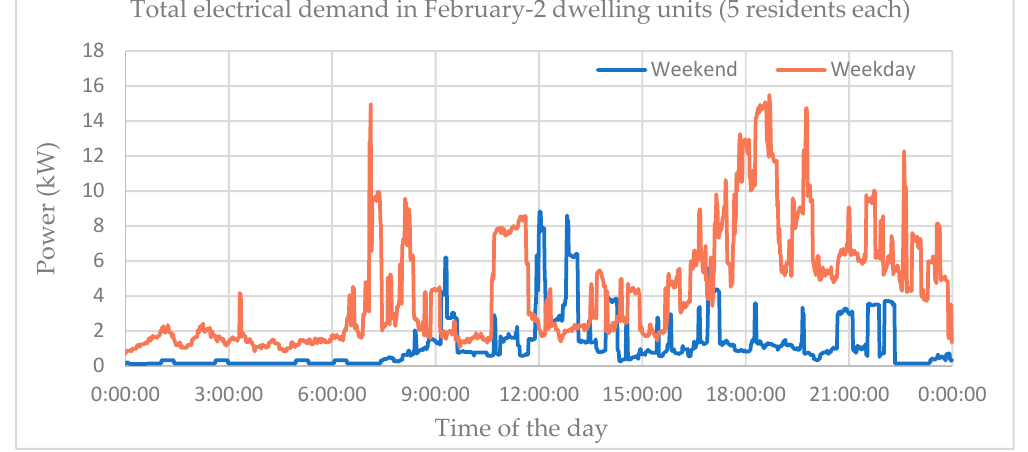
Figure 10. Total electricity demand for two dwelling units in February.